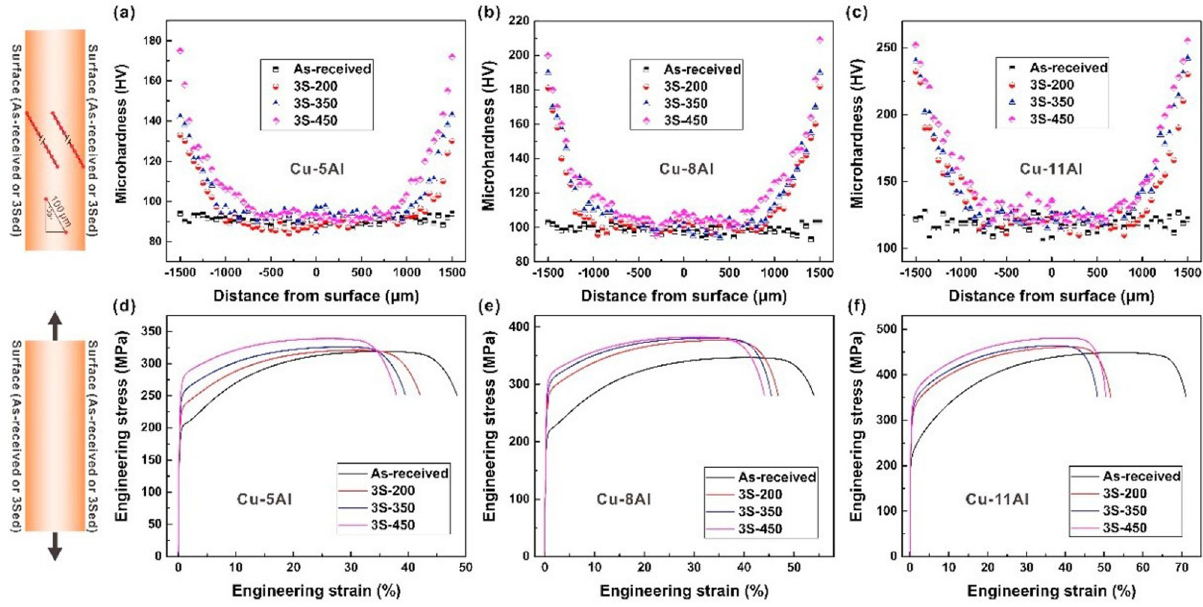
Figure 11: Microhardness and tensile strength curves of the Cu – Al alloy annealed at 400, 450, and 500°C: ( a – c ) microhardness and ( d – f ) tensile strength [ 142 ] .